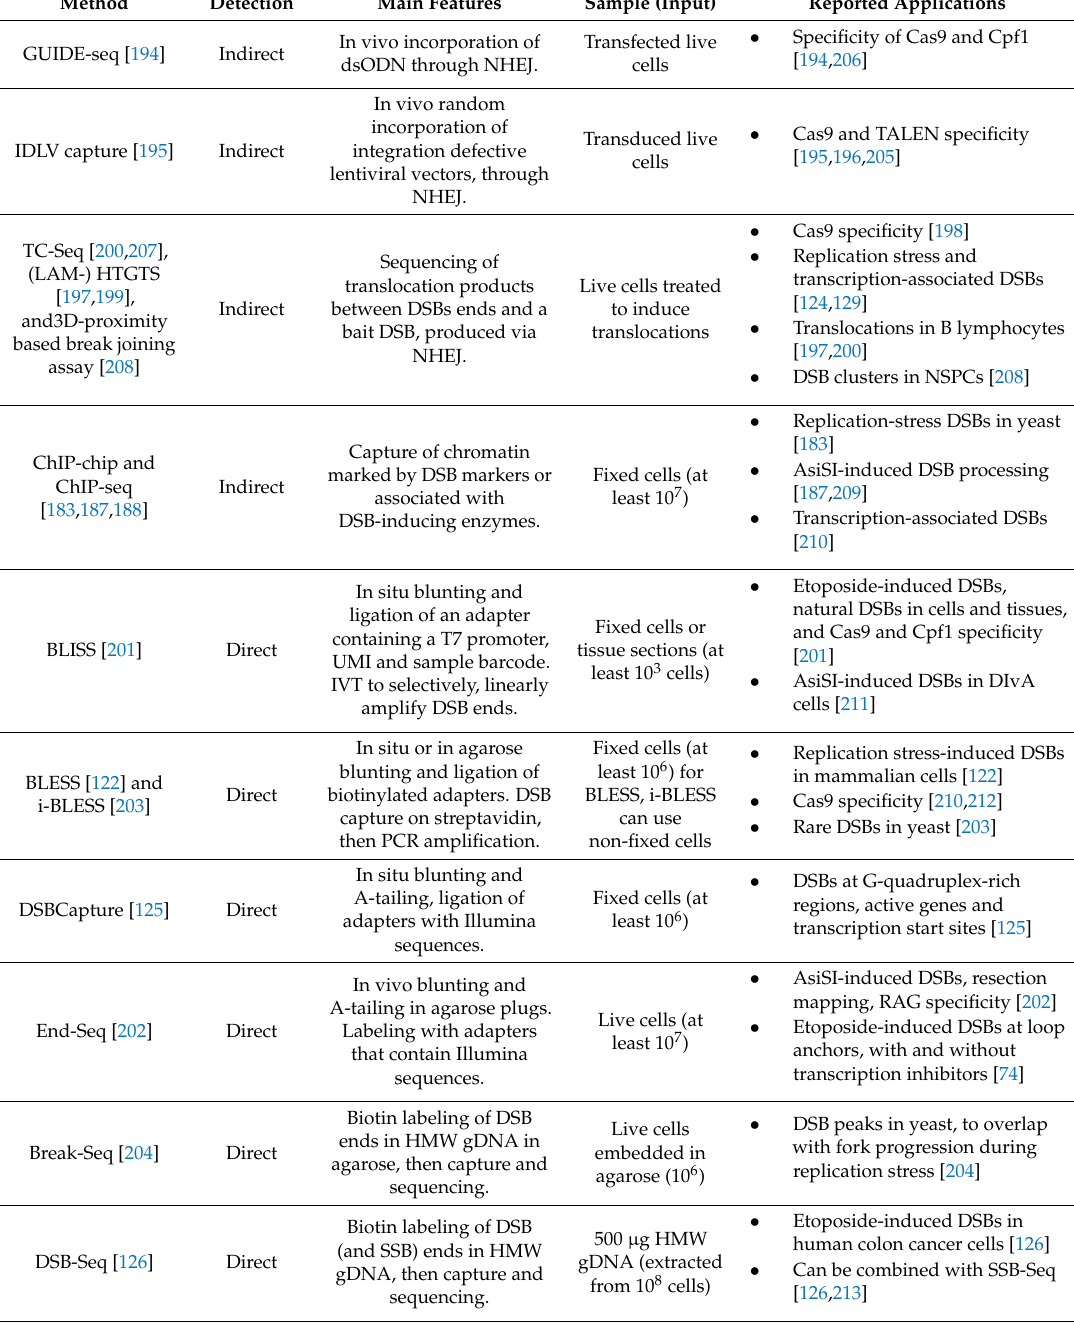
Table 1. Methods for genome-wide nucleotide-resolution DSB